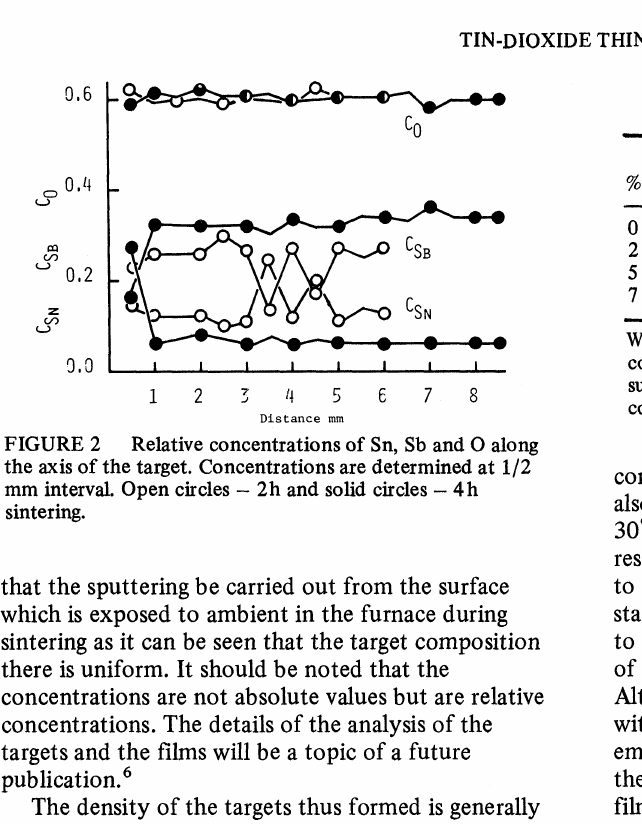
Relative concentrations of Sn Sb and O alon& the ais of the tar&et. Concentrations are determined at